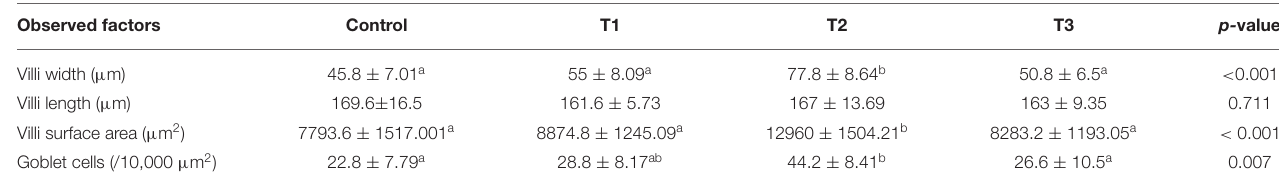
TABLE 4 | Histomorphological data of hindgut collected from tilapia, O. niloticus , after 56 days of feeding trial with silica NPs. Observed